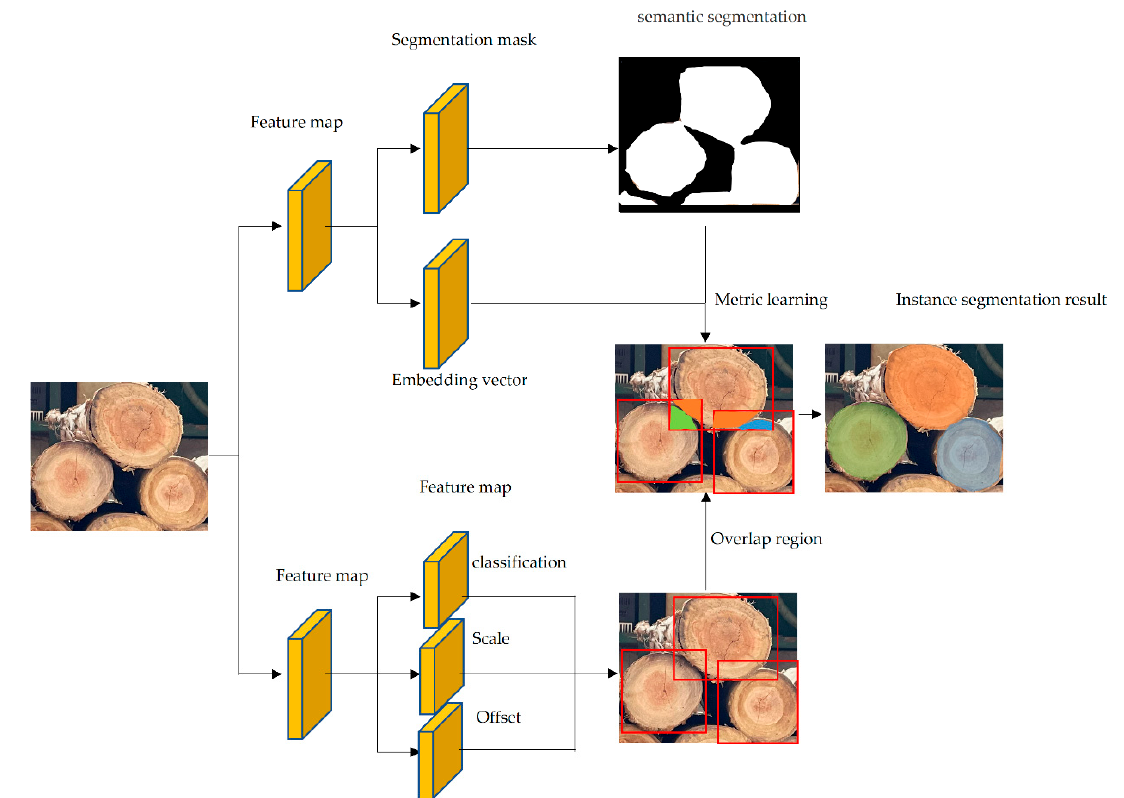
Figure 1. A simplified schematic diagram of the fast instance segmentation method. The red rectangle represents the detection results generated by object detection model. Masks of different colors represent the results produced by the instance segmentation model, and different colors represent different log faces.